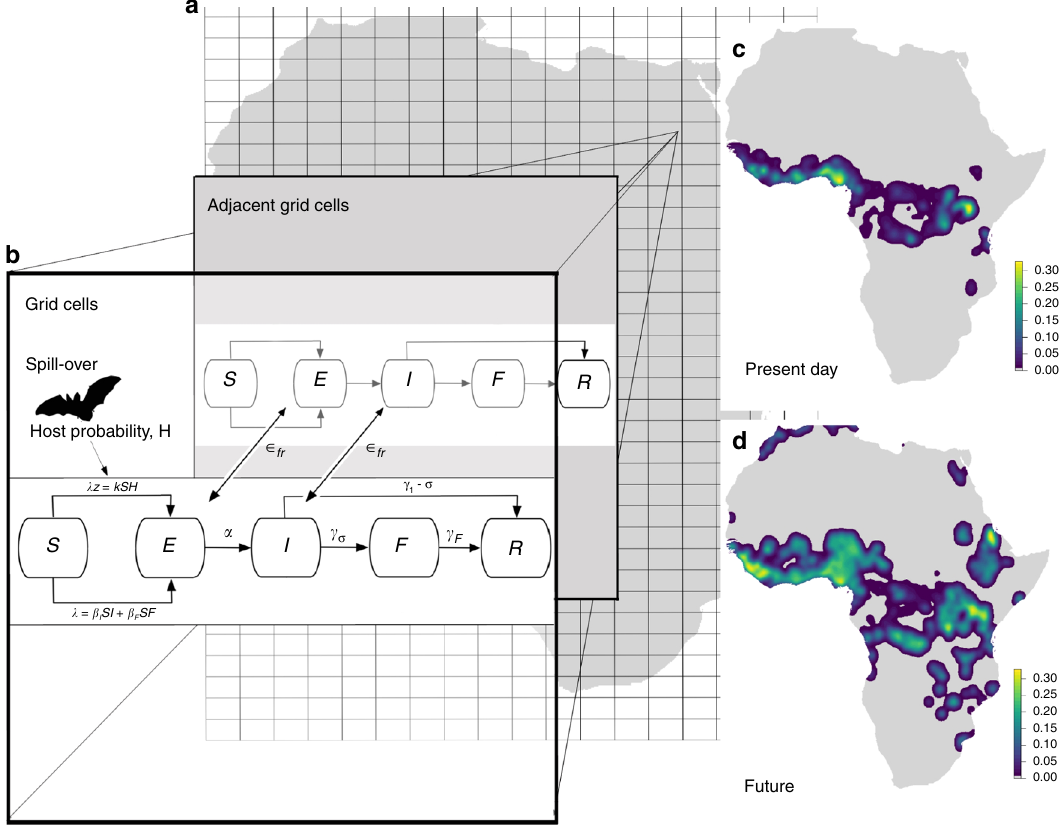
Fig. 2 Environmental Mechanistic Model (EMM) EBOV Simulation Schematic. Within 0.0416° (5.6 km at equator) grid cells across the globe ( a ), we used a SEIFR ( Susceptible, Exposed, Infectious, Funeral and Removed ) disease compartmental model ( b ), to estimate the number of people in each compartment. S – E transmission rate was determined for each grid cell by calculating the force of zoonotic infection (between hosts and humans) λ z , and within human populations λ (see Methods). Travel of exposed or infectious individuals between grid cells occurred across existing road and fl ight transport networks, with transmission rate ε fr . Mean transition rates used as the starting parameters for simulations were as follows: α for E – I was calculated as the reciprocal of incubation time in days ( α = 1/7), γ σ ( I – F transition rate) was the product of the probability of the reciprocal of days infectious ( γ = 1/9.6) and maximum poverty-weighted case fatality rate ( σ = 0.78), γ 1- σ ( I – R transition rate) was the product of the probability of the reciprocal of days infectious ( γ = 1/9.6) and probability of recovering (1- σ ), and γ F ( F – R transition rate) was the reciprocal of the burial time of 2 days. Each simulation was run 2500 times